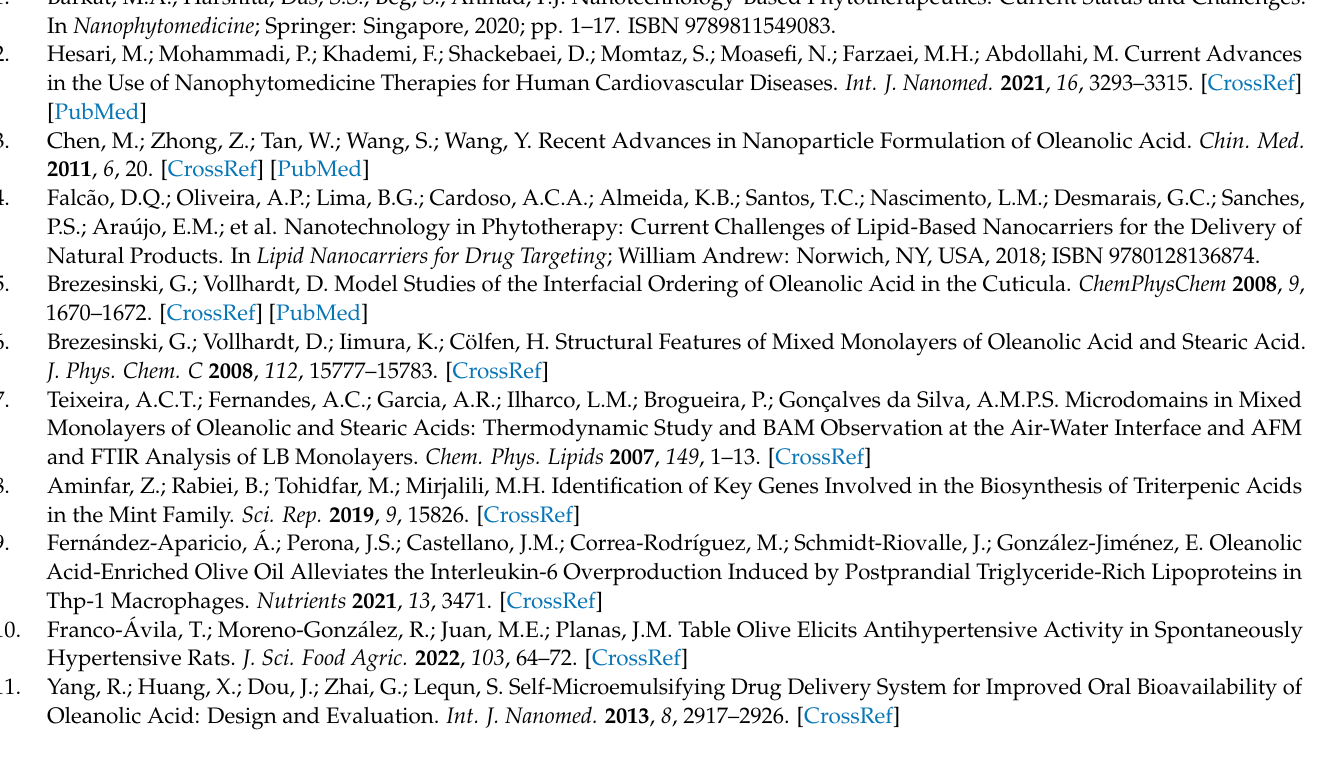
Figure S2: An example graph of the π -A isotherm (A) and the Cs − 1 vs. π (B) with the characteristic values highlighted; Table S1: The characteristic values determined based on the π –A isotherms and compression moduli of OLA, OA and their mixtures; Figure S3: An example graph of the relative area A/A 0 vs. time and the surface pressure vs. time, varying significantly due to the oscillation (A) and close-up emphasizing the peak asymmetry of the surface pressure